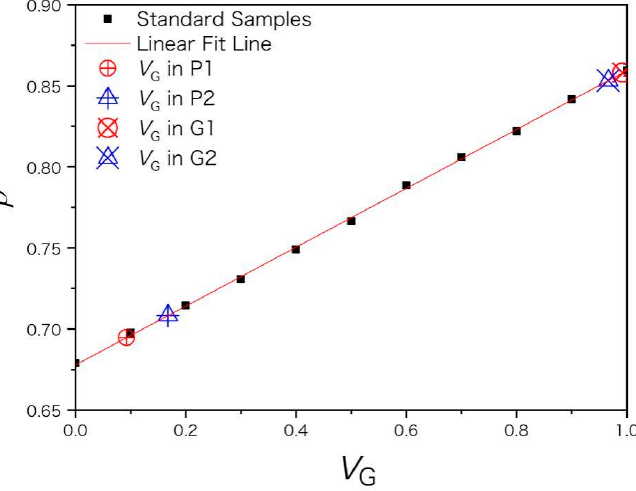
Figure 1. The red line is a linear fit of the volume fraction of xylene v G and density ρ of standard samples (marked in black squares). The real samples of recovered extractants (P1, P2 and G1, G2) are marked by larger symbols along the fitted line. ρ is in unit of g/mL.